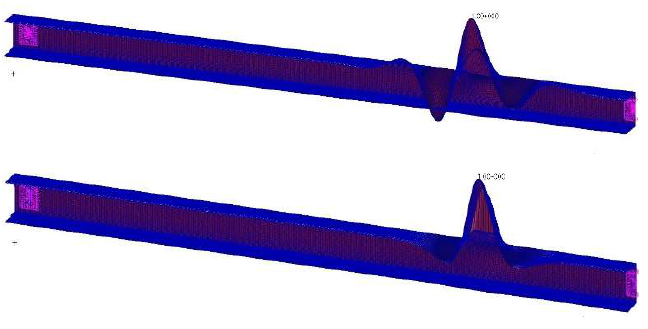
Figure 7. FE buckling analysis.